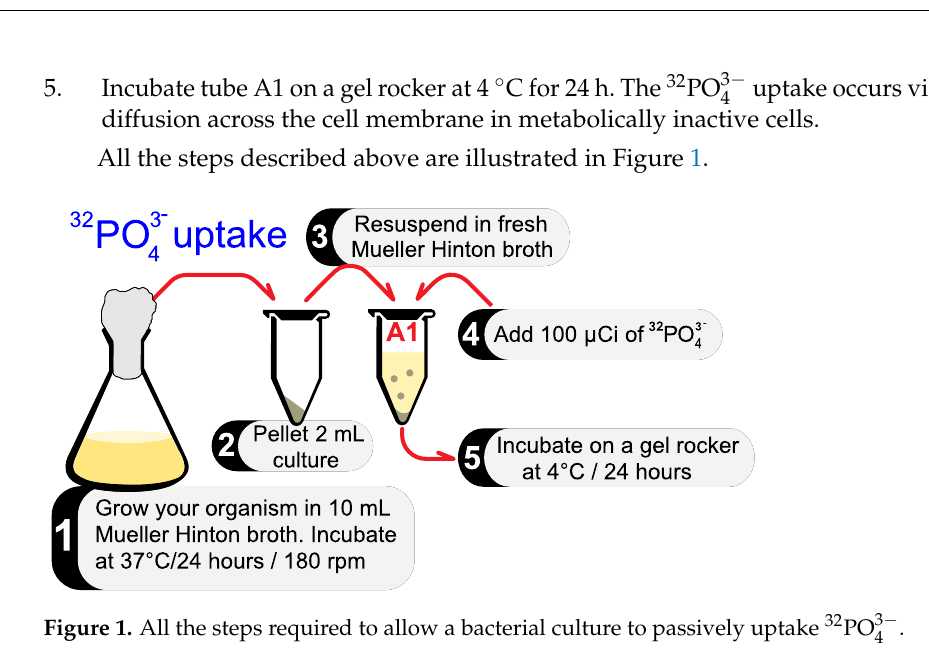
Figure 1. All the steps required to allow a bacterial culture to passively uptake 32 PO 3 − 32 PO 3 − 4 is very easily introduced into the bacterial cytoplasm via passive diffusion 132 after incubation for 24 hours. Care must be taken to incubate your culture at 4 ◦ C to suspend 133 bacterial metabolism and prevent the incorporation of phosphate into biomolecules.